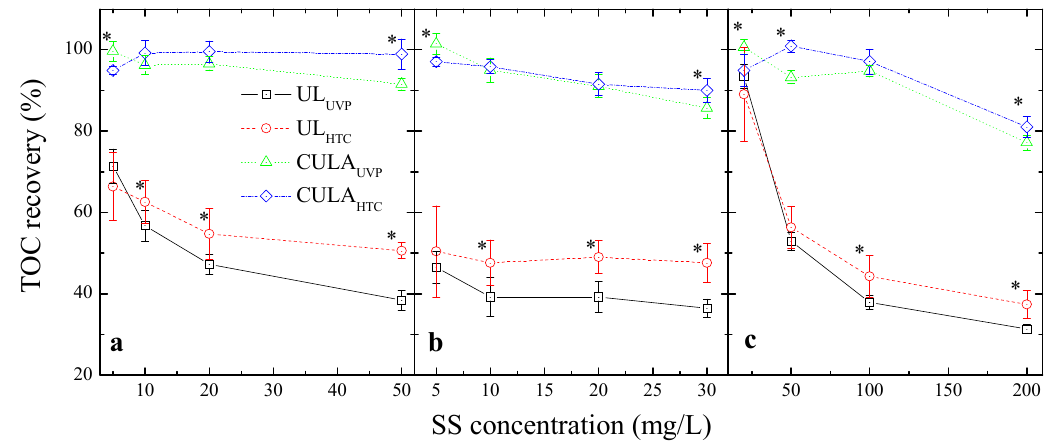
Figure 1. Changes in total organic carbon (TOC) recovery (%) of water samples containing